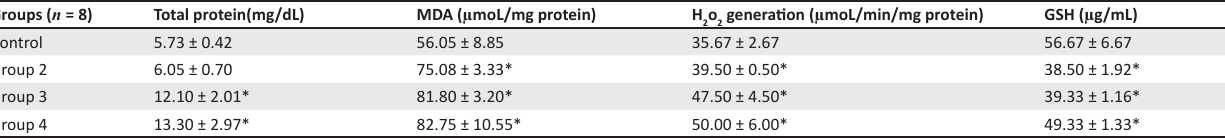
TABLE 1: Effect of calcium hypochlorite on markers of oxidative stress and serum glutathione. Groups ( n =